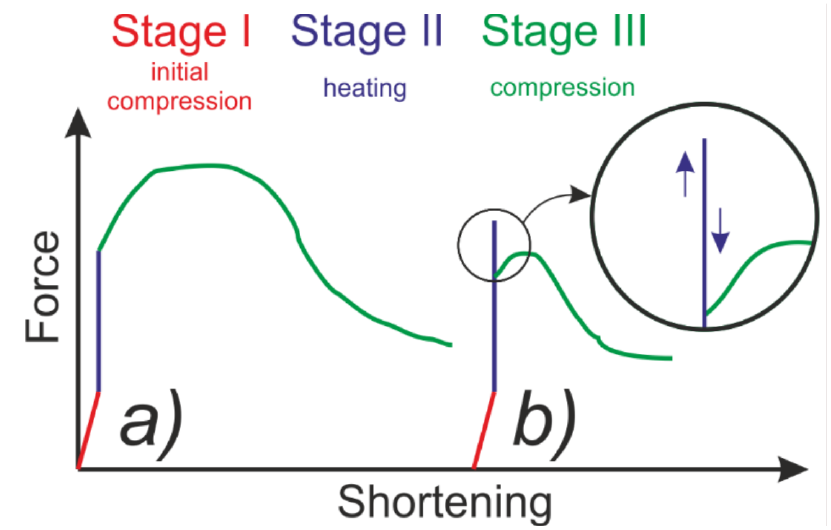
Figure 13. Standard test scheme ( a ) and test scheme with thermal buckling ( b ).